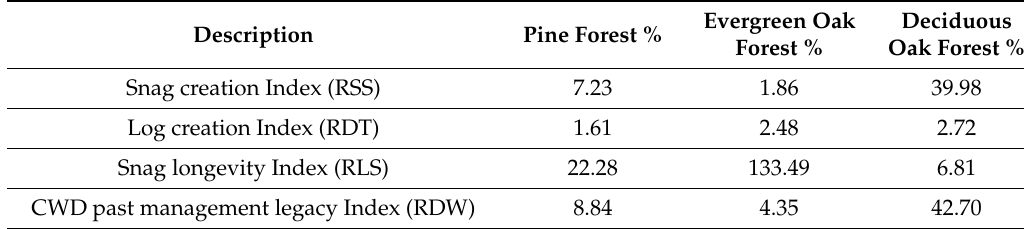
Table 6. Deadwood dynamic indices in the three studied forest types.